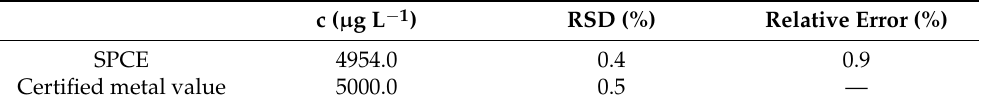
Table 3. Total concentrations of Ni(II) determined in a wastewater certified reference material (SPS- WW2) by AdSV on SPCE by standard addition calibration method at ammonium/ammonia buffer pH 9.2 applying an Ed of − 0.7 V and a td of 120